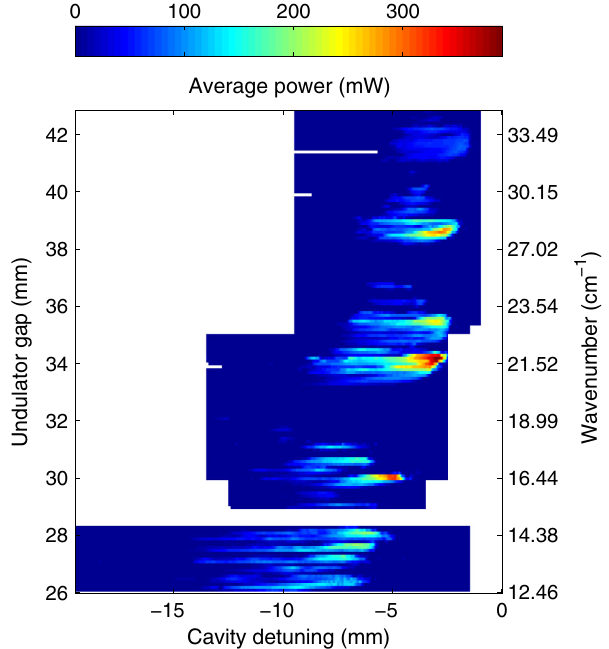
FIG. 1. 2D scan of power (false color) measured at different cavity lengths and undulator gaps. Wave numbers of the optical output as experimentally determined at the given undulator gap values are shown on the right side vertical axis. The measure- ments are performed at a beam energy of 15 MeV. The noncontinuous scanning of FLARE is clearly visible. The shift of the detuning curves to the longer cavity lengths with increasing wave number is due to the dispersion of the